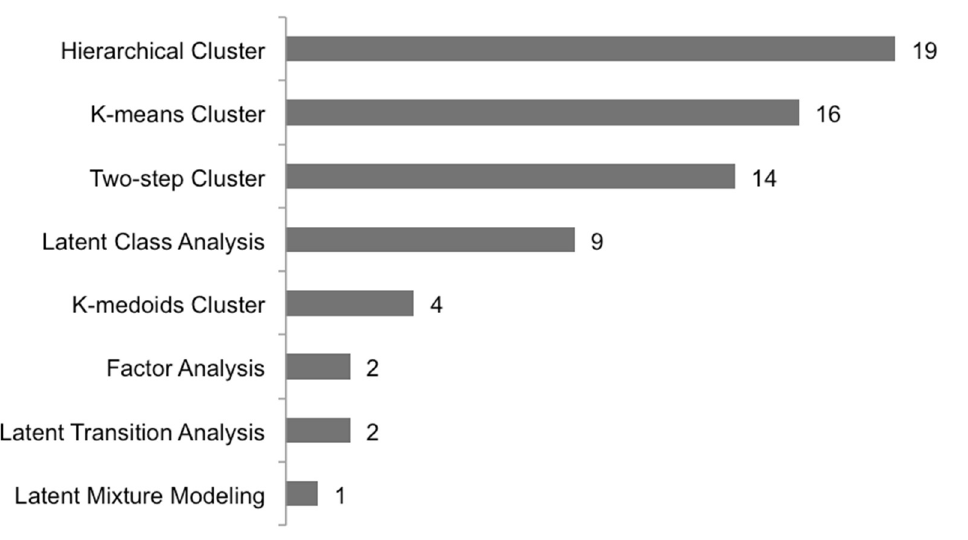
Figure 2. Data-driven method chosen for asthma phenotyping ordered by absolute frequency of use.